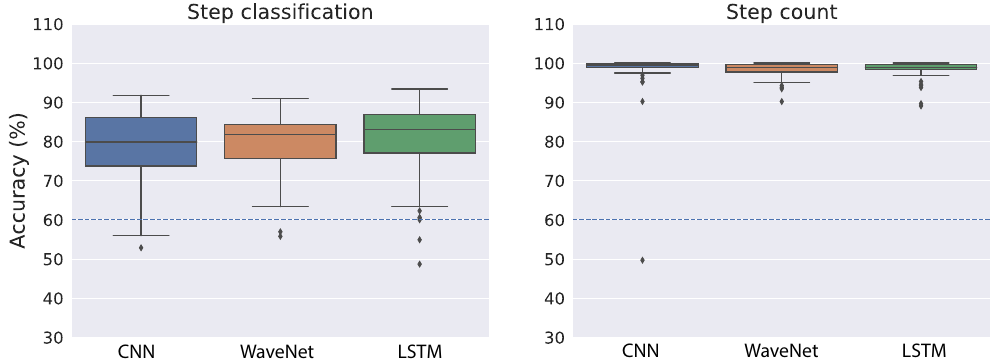
Figure 6. Cross-validation results on the public dataset using raw acceleration as the input to neural network models. The accuracy measures were taken from 70 shuffled splits of training and validation sets. The dashed blue line indicates performance achieved from a previous study